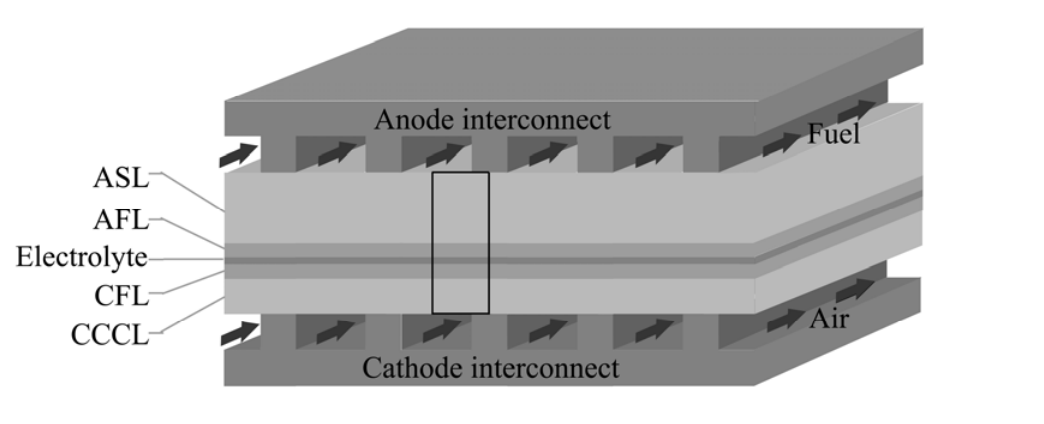
Figure 1. Schematic diagram of an anode-supported planar SOFC stack cell